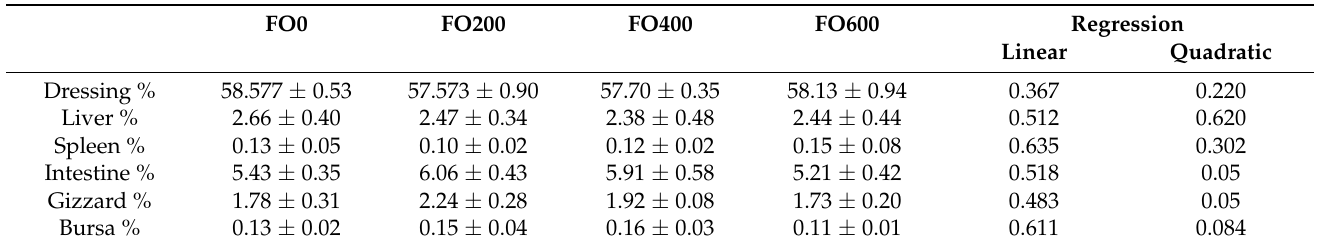
Table 4. Effect of FO Supplementation on the Percentages of Dressing, Internal Organs, and Immune Organs